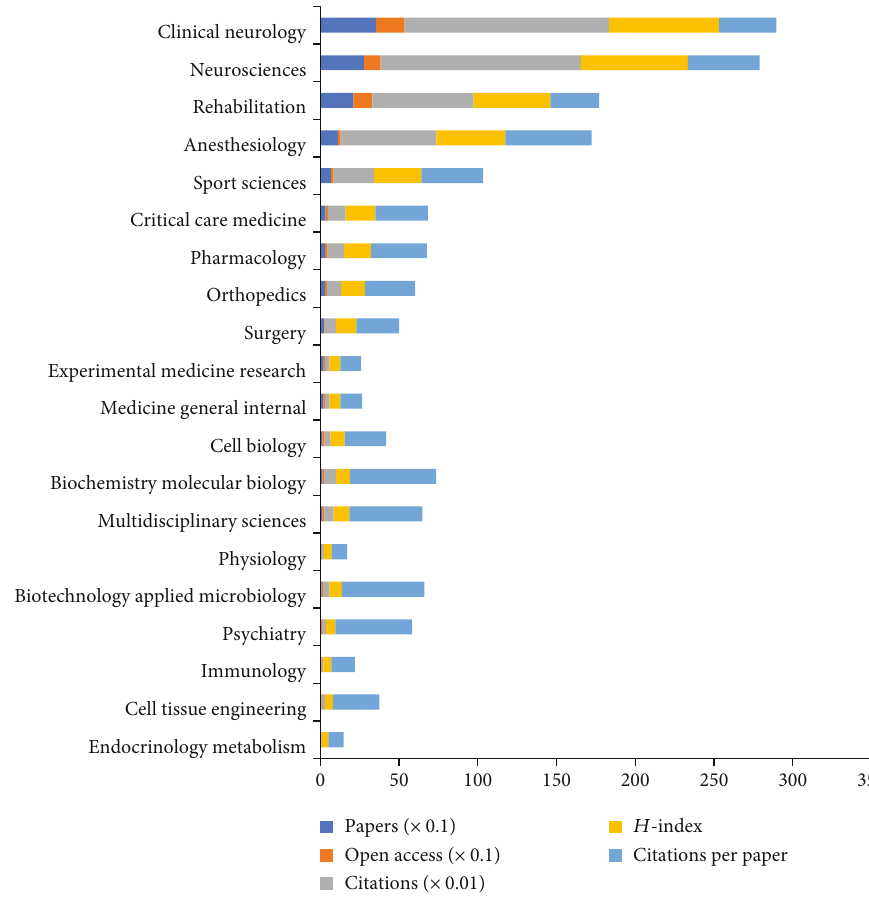
Figure 4: The number of papers, citations, citations per paper, and open-access papers and H -index of the top 20 subject categories of Web of